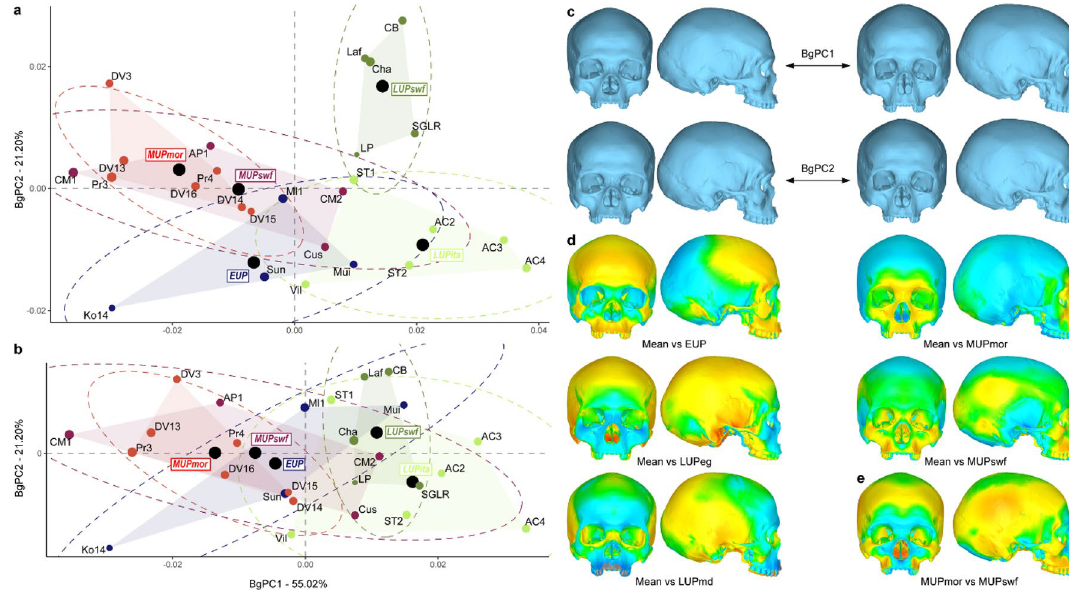
Figure 4. Between-group PCA discriminating the EUP, MUPswf, MUPmor, LUPswf and LUPita samples. ( a ) morphospace of the bgPCA; ( b ) morphospace after cross-validation; ( c ) shape changes for bgPC1 and bgPC2; ( d ) surface deviation spectrum showing the shape difference between the shape difference between the mean shape of the entire sample versus the mean shape of each group. For each group, black circles indicate the position of the centre, and the dotted ellipses represent the 90% confidence intervals. The size of the data points reflects the centroid size of the specimens.